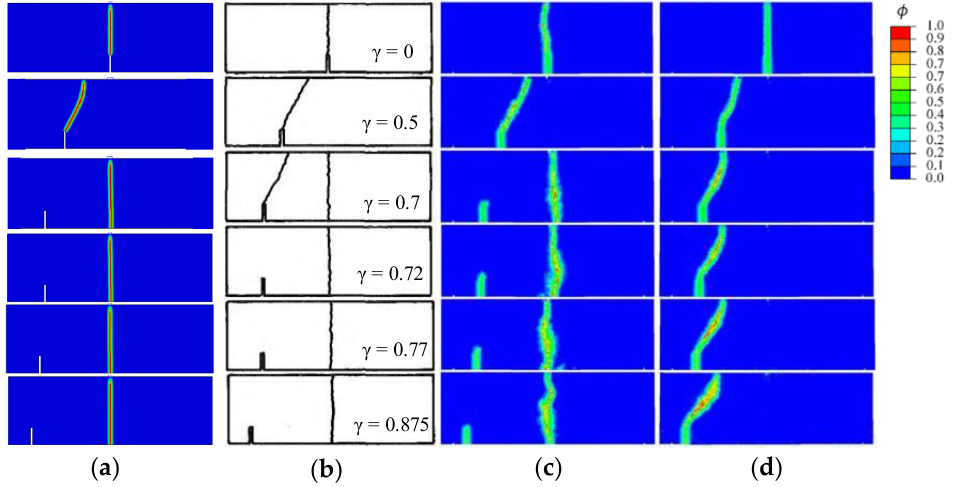
Figure 6. Notched concrete beam ( γ = 0) under three-point bending: finite element mesh.